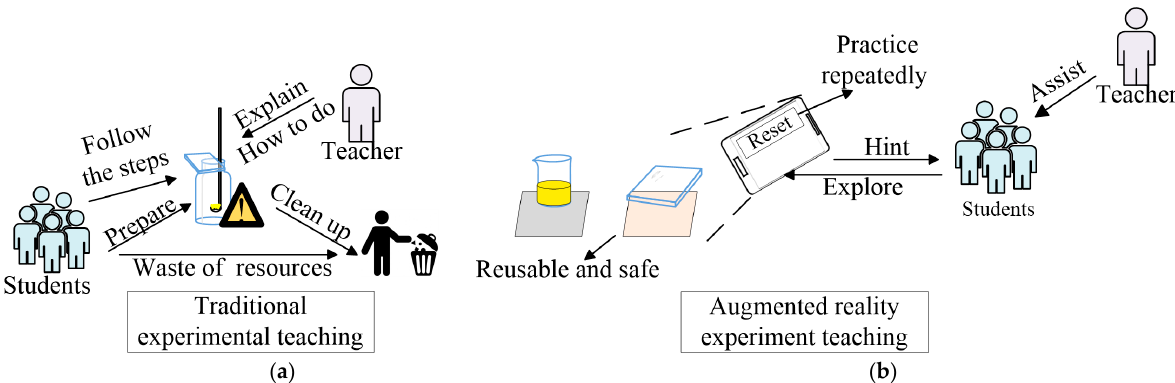
Figure 4. Comparison of two teaching methods: ( a ) teaching method of traditional chemistry experiments, ( b ) teaching method of the proposed virtual chemistry laboratory.